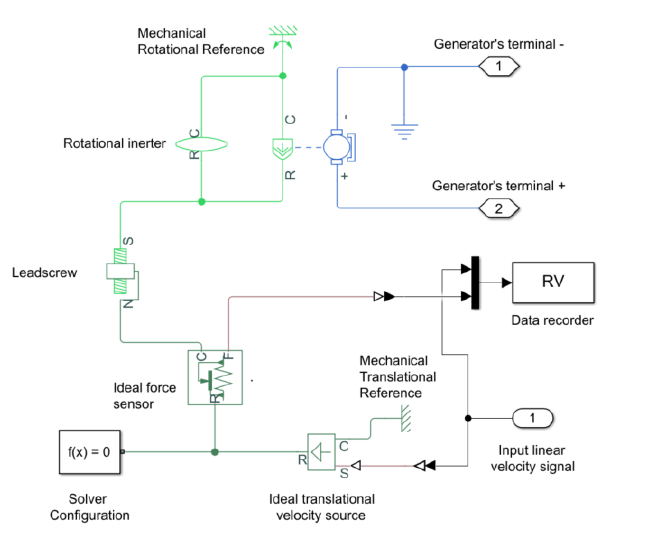
Figure 9. Simscape model for a ball-screw shock